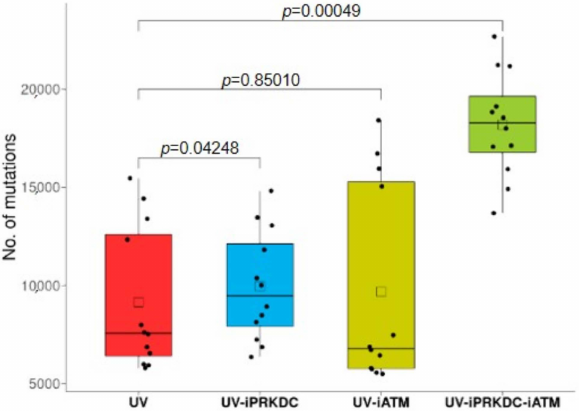
Figure 5. The number of mutations show a significant increase in samples treated with UV and either PRKDC or both inhibitors. Boxplot showing the number of mutations including SNVs and indels in the samples treated with UV, iPRKDC, iATM, or both. The mean numbers of mutations in each category are represented by